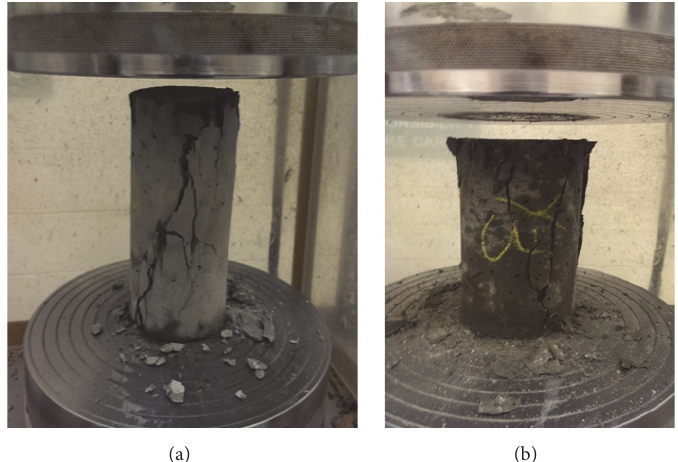
Figure 9: Crack patterns at ultimate failure load: control specimen (a) and specimen (Y3) (b). Reduced cracks in Y3